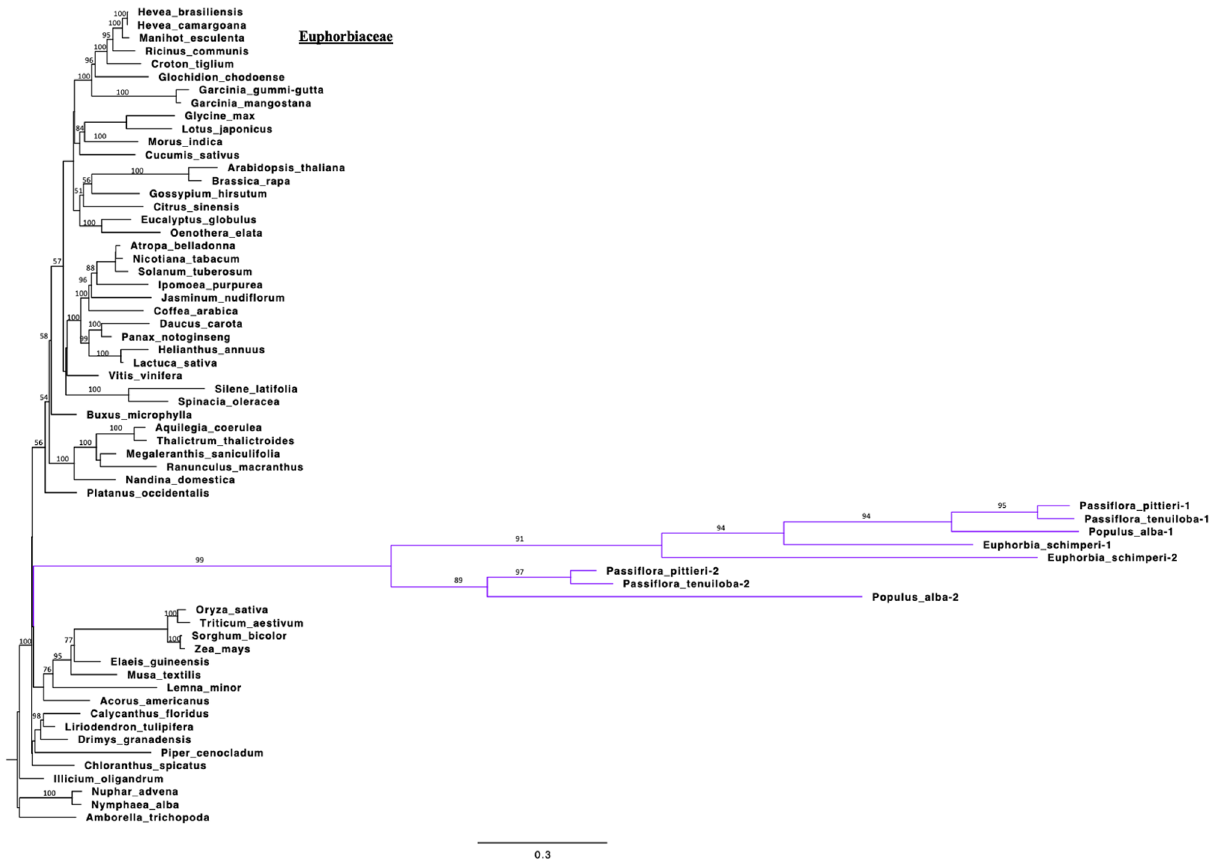
Figure 7. ML phylogram of 60 taxa based on rps16 gene sequences. Nuclear copies of rps16 are indicated in bold purple. Bootstrap support values > 50% are shown at nodes. Scale bar indicates a phylogenetic distance of 0.3 nucleotide substitutions per